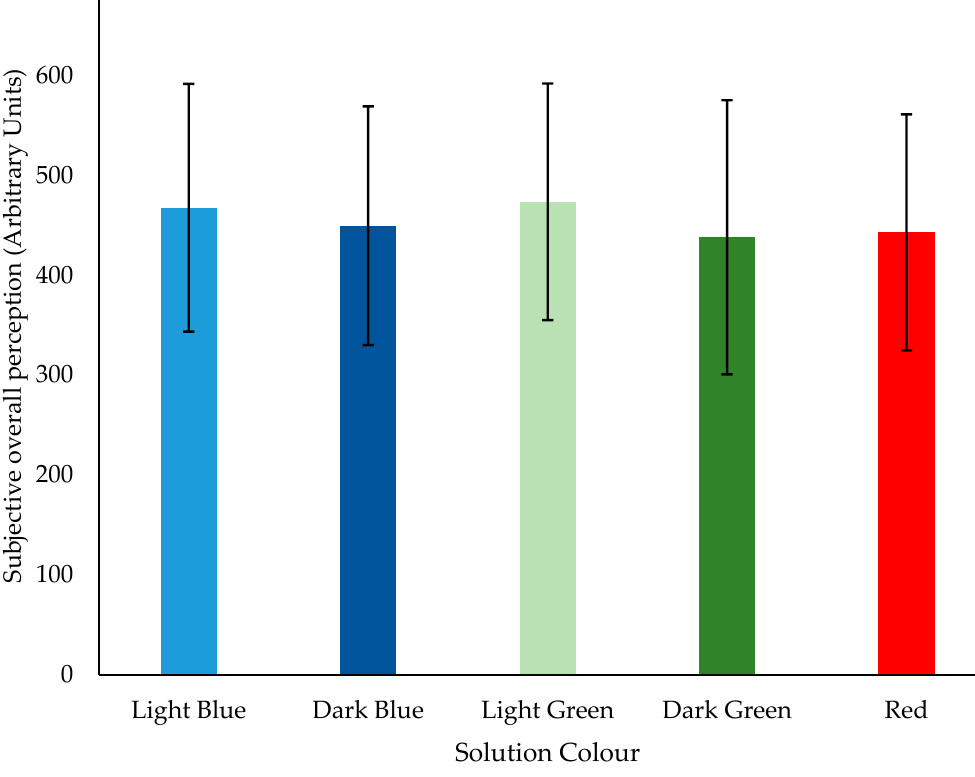
Figure 2. Subjective overall perception (Arbitrary Units) for solution colour, expressed as Mean VAS rating per solution colour ± 1 S.D.